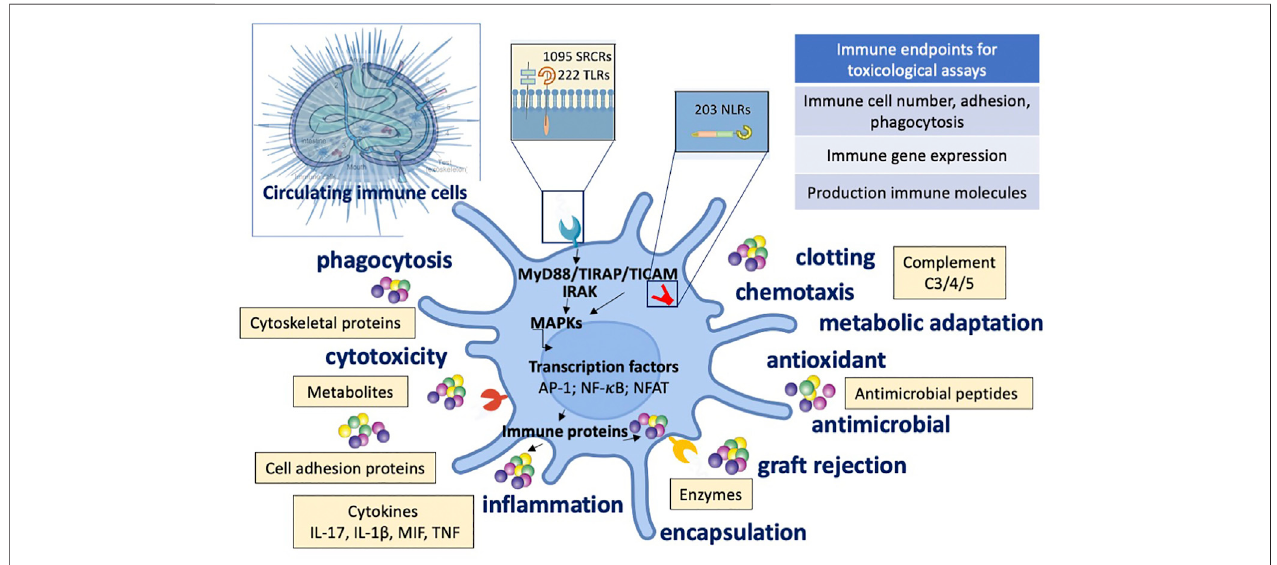
FIGURE 3 | Immune defensive reactivity of sea urchin to external stimuli and toxicants. Schematic depiction of the immune functions, molecules, and signalling pathwaysactivated during the sea urchindefensiveresponsetothreats and toxicants. Upper left: sea urchin anatomy. SRCR:ScavengerReceptorCysteine-Rich; TLR: Toll-like receptor; NLR NOD-like